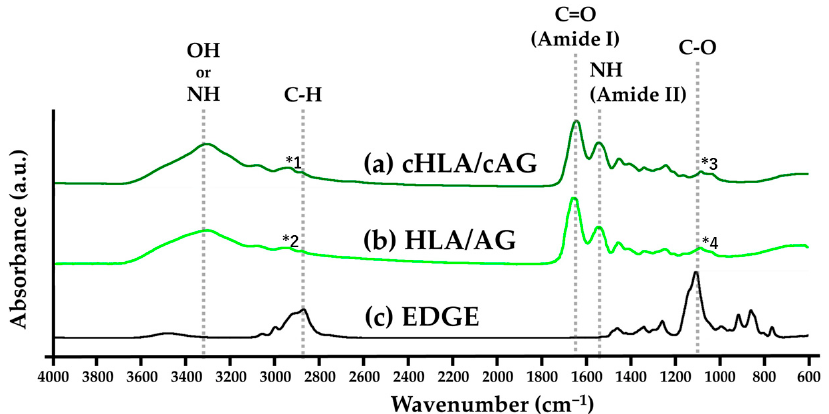
Figure 2. FTIR charts of ( a ) cHLA/cAG, ( b ) hyaluronic acid/alkaline gelatin (HLA/AG), and ( c ) ethylene glycol diglycidyl ether (EDGE). Note: cHLA/cAG was a cross-linked solid, HLA/AG was an uncross-linked liquid, and EDGE was a liquid cross-linker. The symbol * means the selected characteristic peak of FITR charts. The numbers are sequential order of appearance.